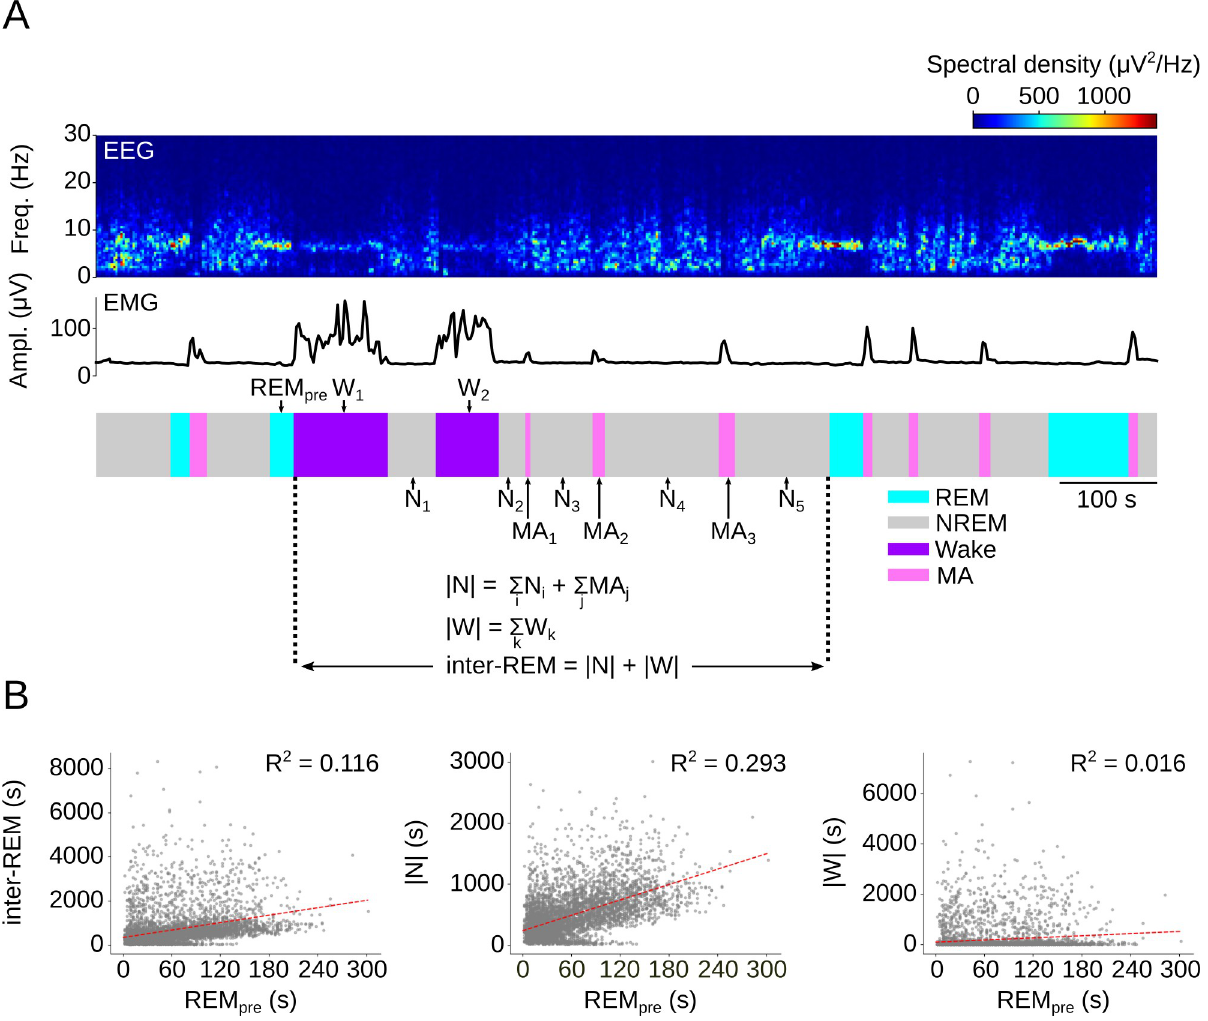
Fig 1. Correlation between REM sleep duration and inter-REM interval. (A) Example EEG power spectrogram, EMG amplitude, and hypnogram with definitions of terms. REM pre , duration of the preceding REM sleep episode; inter-REM, duration of subsequent interval till next REM episode; |W|, sum of the durations of all wake episodes during the inter-REM interval; MA, microarousal (wake bouts � 20 s); |N|, sum of the durations of all NREM episodes (including MAs) during the inter-REM interval. (B) Scatter plots with REM pre on the x-axis and subsequent inter-REM duration (left), |N| (middle), and |W| (right) on the y-axis. The results of linear regression fits are shown in red (P < 0.00001 for all 3 slopes, n = 5098 sleep cycles from 72 mice recorded during the light